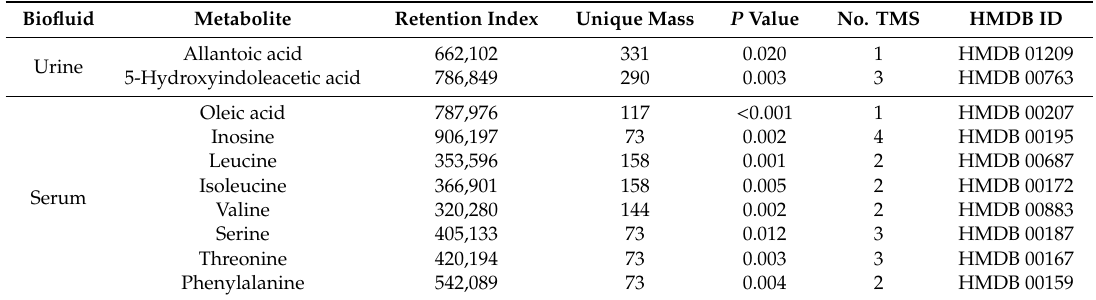
Table 2. Compounds detected by GC-TOF-MS global profiling of NHP biofluids after 4 Gy γ radiation